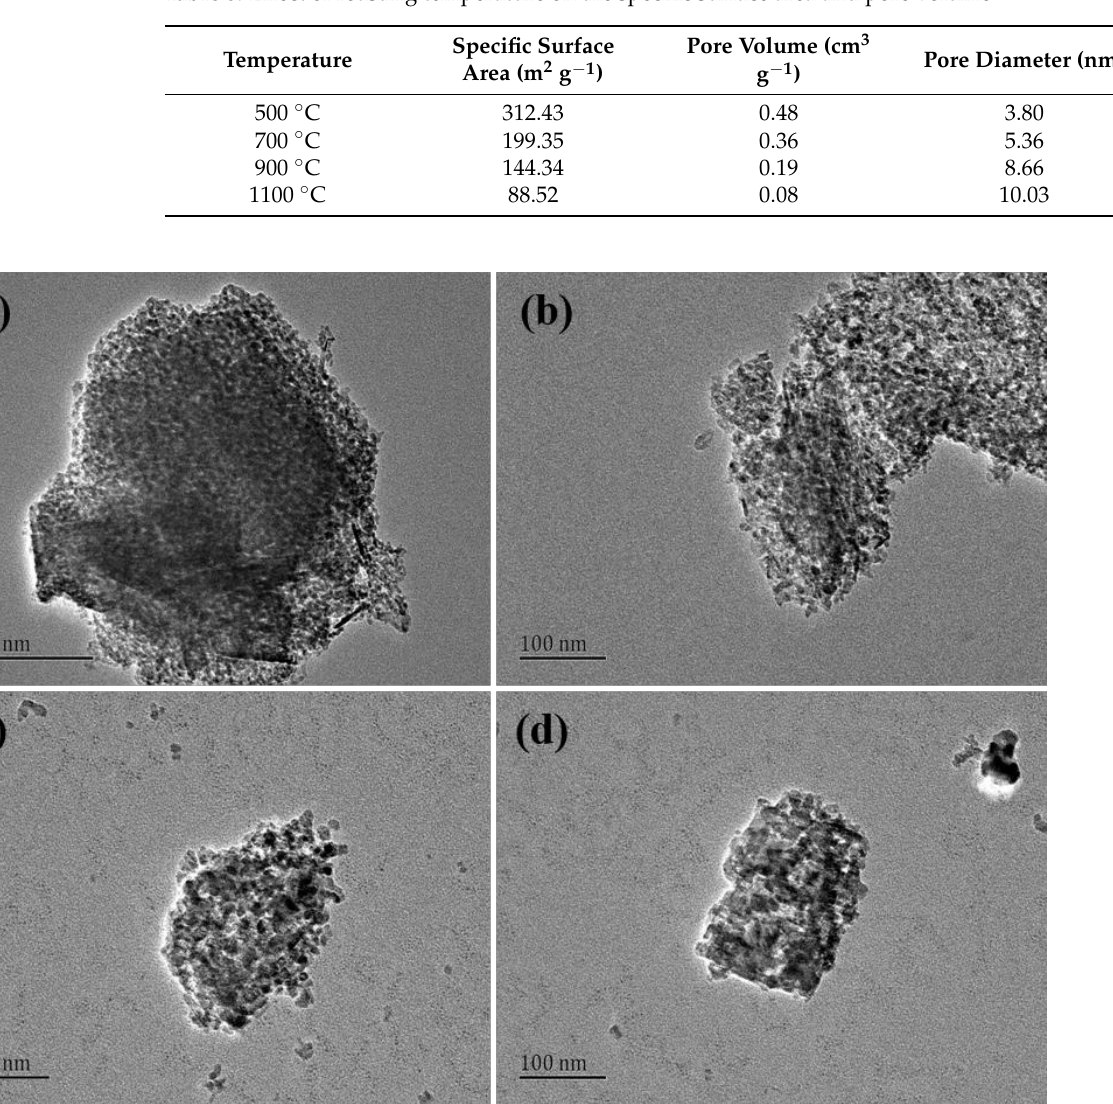
Table 8. Effect of roasting temperature on the specific surface area and pore volume.